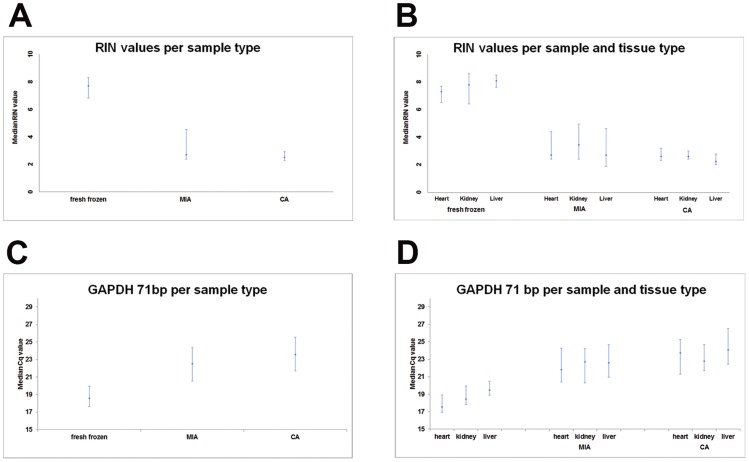
RNA integrity and GAPDH expression in fresh frozen, MIA and CA samples.
Fig. 1A shows median RIN values (X-axis) of fresh frozen, MIA and CA samples (Y-axis). The fresh frozen samples, taken from surgical specimens, yielded high quality RNA. Both types of post mortem samples MIA and CA yielded RNA of lower quality. In Fig. 1B the samples are divided into 3 tissue types; heart, kidney and liver respectively. In Figs. 1C and 1D RT-qPCR results of the same samples are shown, in the same order. Since all GAPDH RT-qPCR assays in the 6-amplicon size assay showed similar results, only the results of the 71 bp assay are depicted here. The Cq value (Y-axis) obtained in fresh frozen samples is low, i.e. the GAPDH expression level is high. In the post mortem samples MIA and CA, GAPDH RNA is partly degenerated, resulting in higher Cq values corresponding with lower GAPDH expression levels.